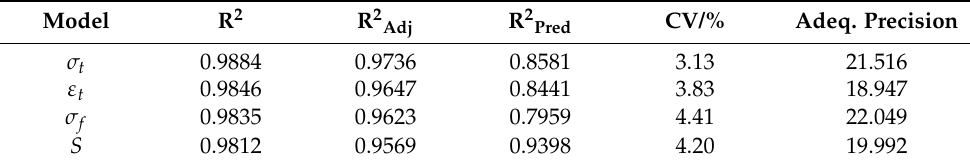
Table 4. Fit statistics for response surfaces of the model.